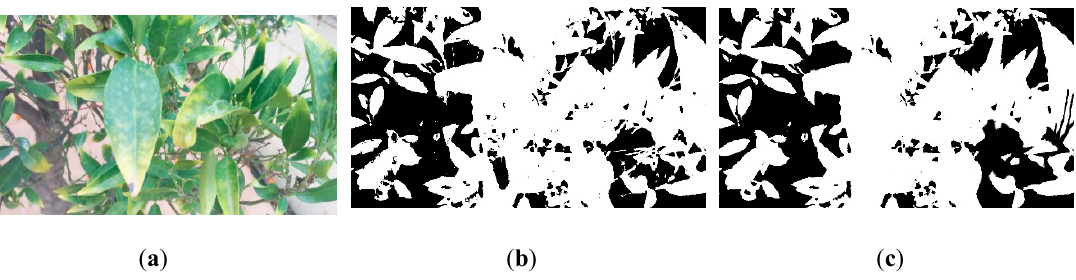
Figure 3. Mask manual edition example. ( a ) original picture; ( b ) clustering classification mask; ( c ) edited mask.